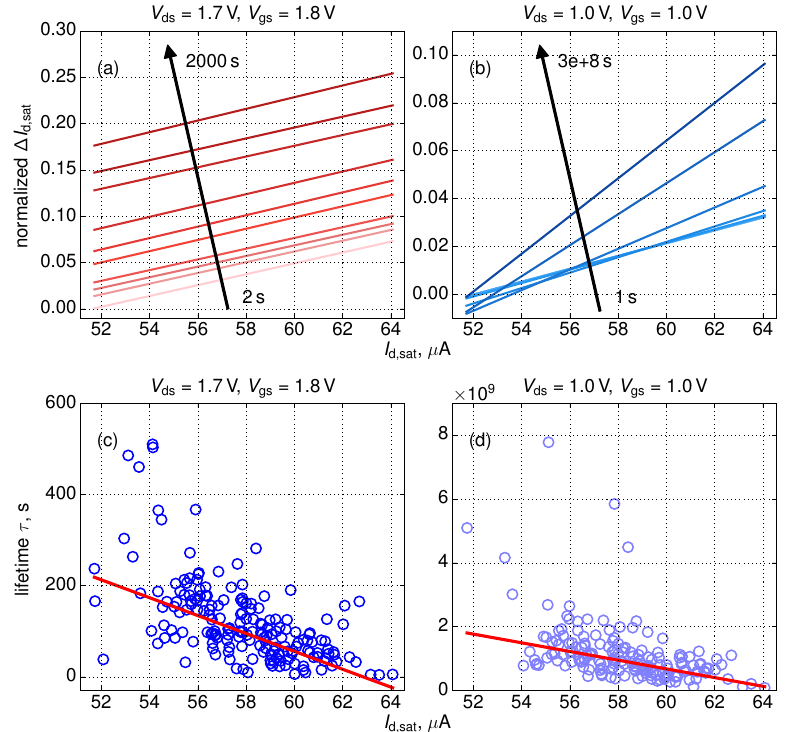
( 0 ) ) dependencies for all stress time steps ( a , b ) and device lifetime d,sat